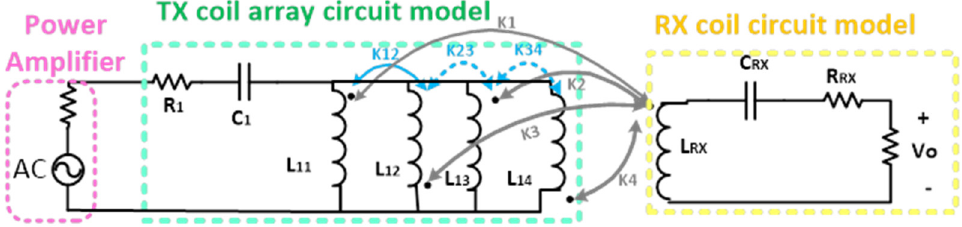
Figure 4. Circuit equivalent model of WPT array. The pink, green and yellow box shows the PA, TX coil tunning and RX coil tunning circuits respectively.